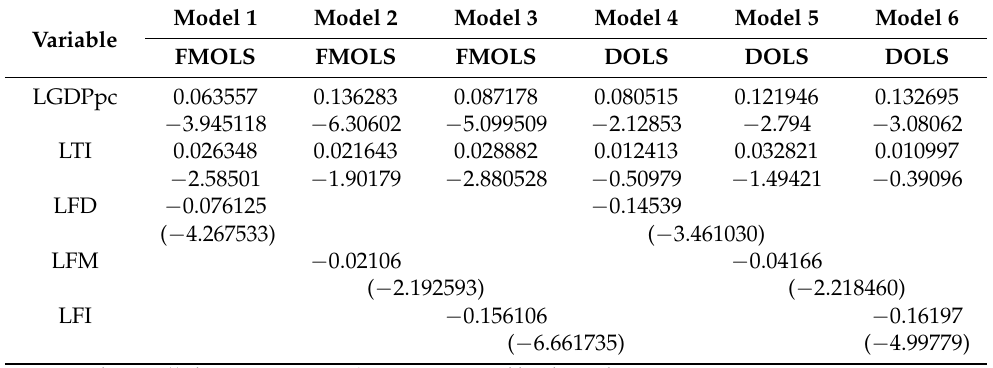
Table 5. FMOLS and DOLS estimates of the impact of IT and FD (FM, FI) on IE. Variable